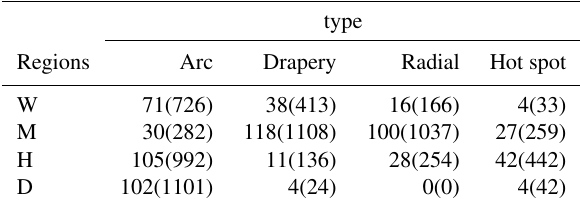
Table 1. The number of images belonging to four auroral types in different auroral active regions, including the number of the testing set in 10-fold cross-validation experiment and all of the images in the ARD (in